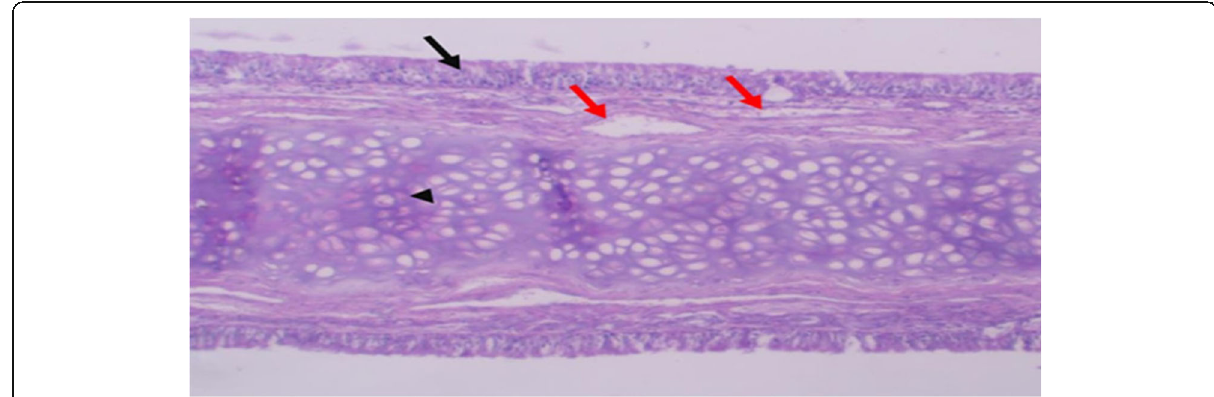
Fig. 1 Nasal mucosa (control group) showing well-organized tissue layers: uniform pseudostratified columnar epithelium (black arrow); overlying connective tissue lamina propria, with scattered uniform blood vessels (red arrows); and underlying cartilage (arrowhead) (H&E,